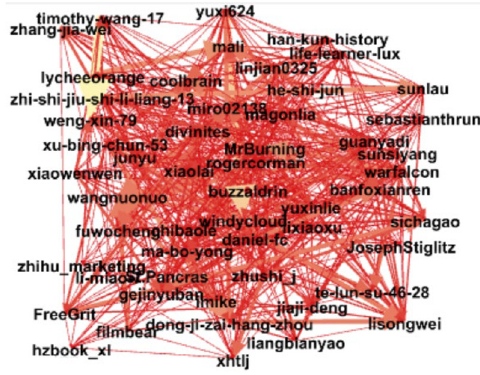
Figure 6. Symmetric matrix